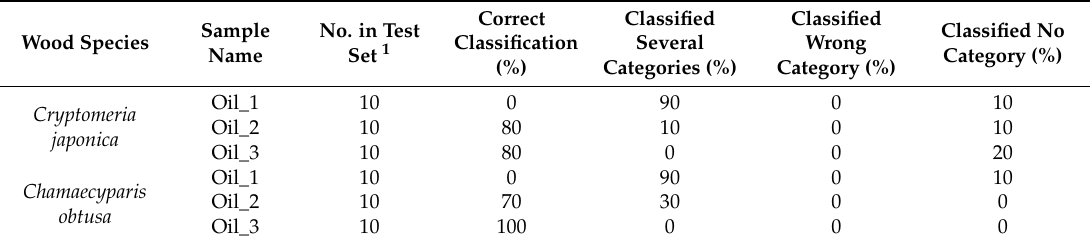
Table 2. Classification results of soft independent modeling of class analogy (SIMCA) with three oil samples ( α = 0.05).